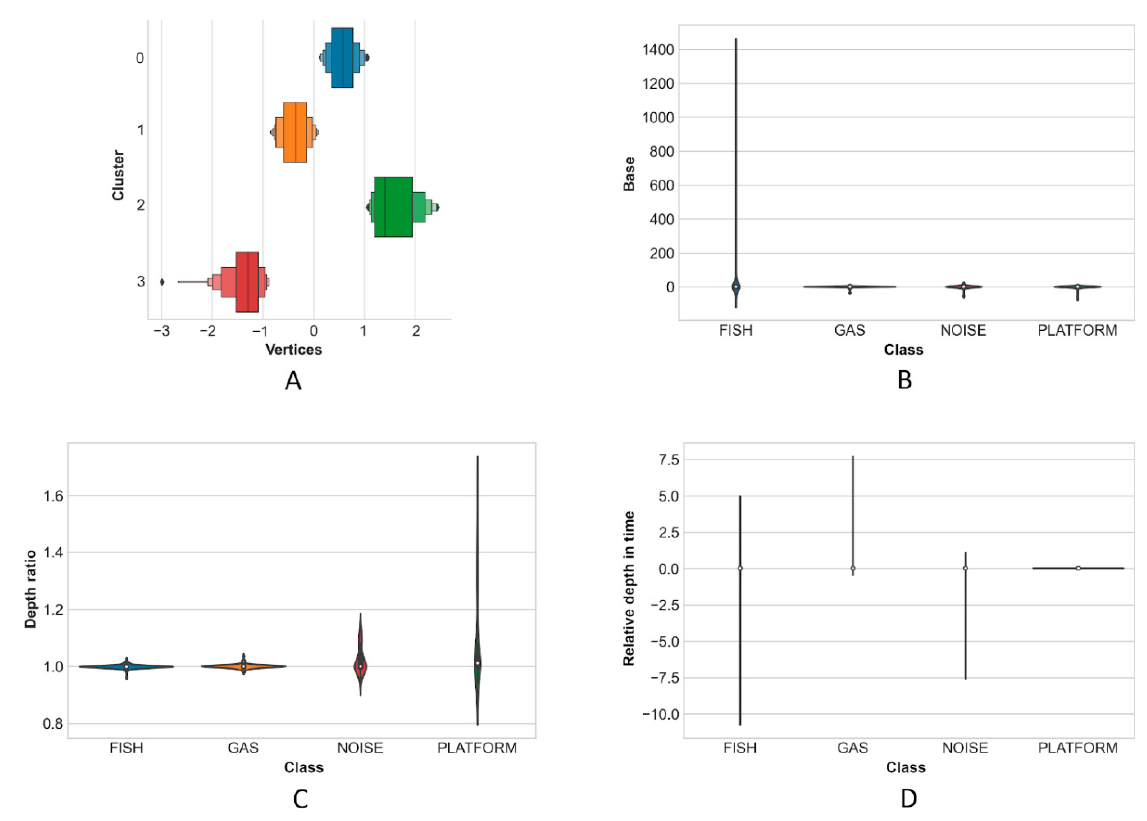
Figure 10. Feature space exploration by kNN Cluster and Vertices ( A ); by Base , describing the shape with low values for oblong targets ( B ); by Depth ratio ( C ); by Relative depth in time ( D ).